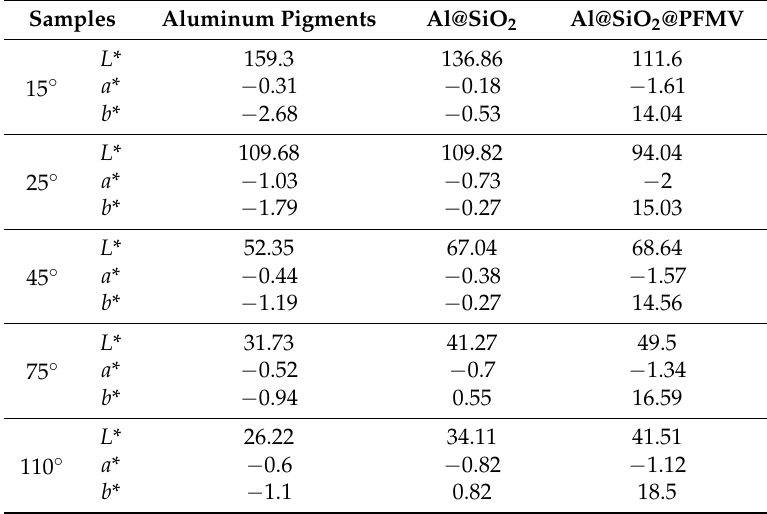
Table 3. The CIE L * a * b * values of aluminum pigments, Al@SiO 2 and Al@SiO 2 @PFMV.